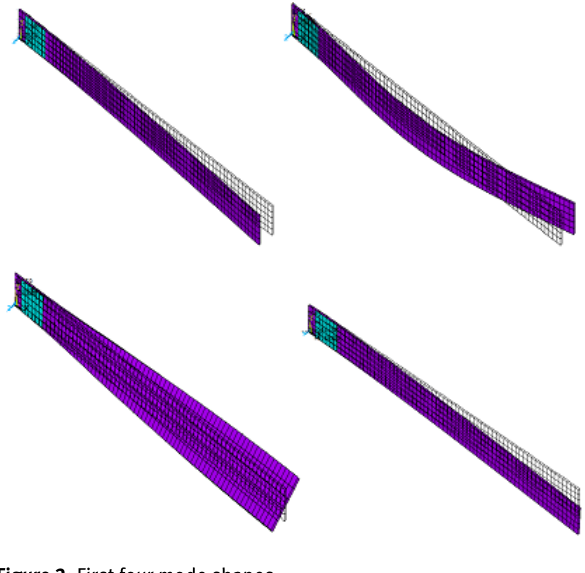
Figure 2: First four mode shapes